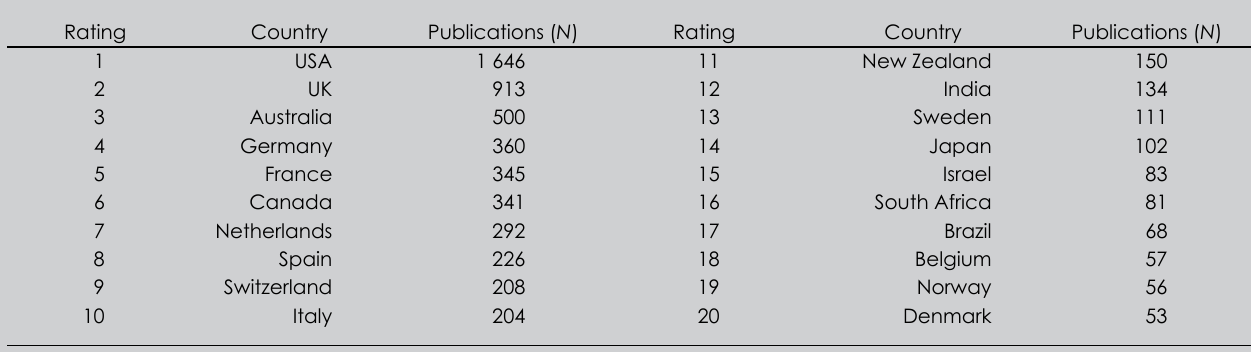
Table I. The 20 most prolific countries with regard to publications on cannabis, 1900 - 2008